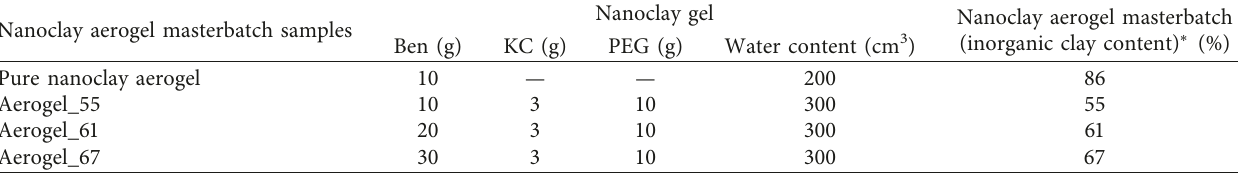
Table 1: Nanoclay aerogel masterbatch